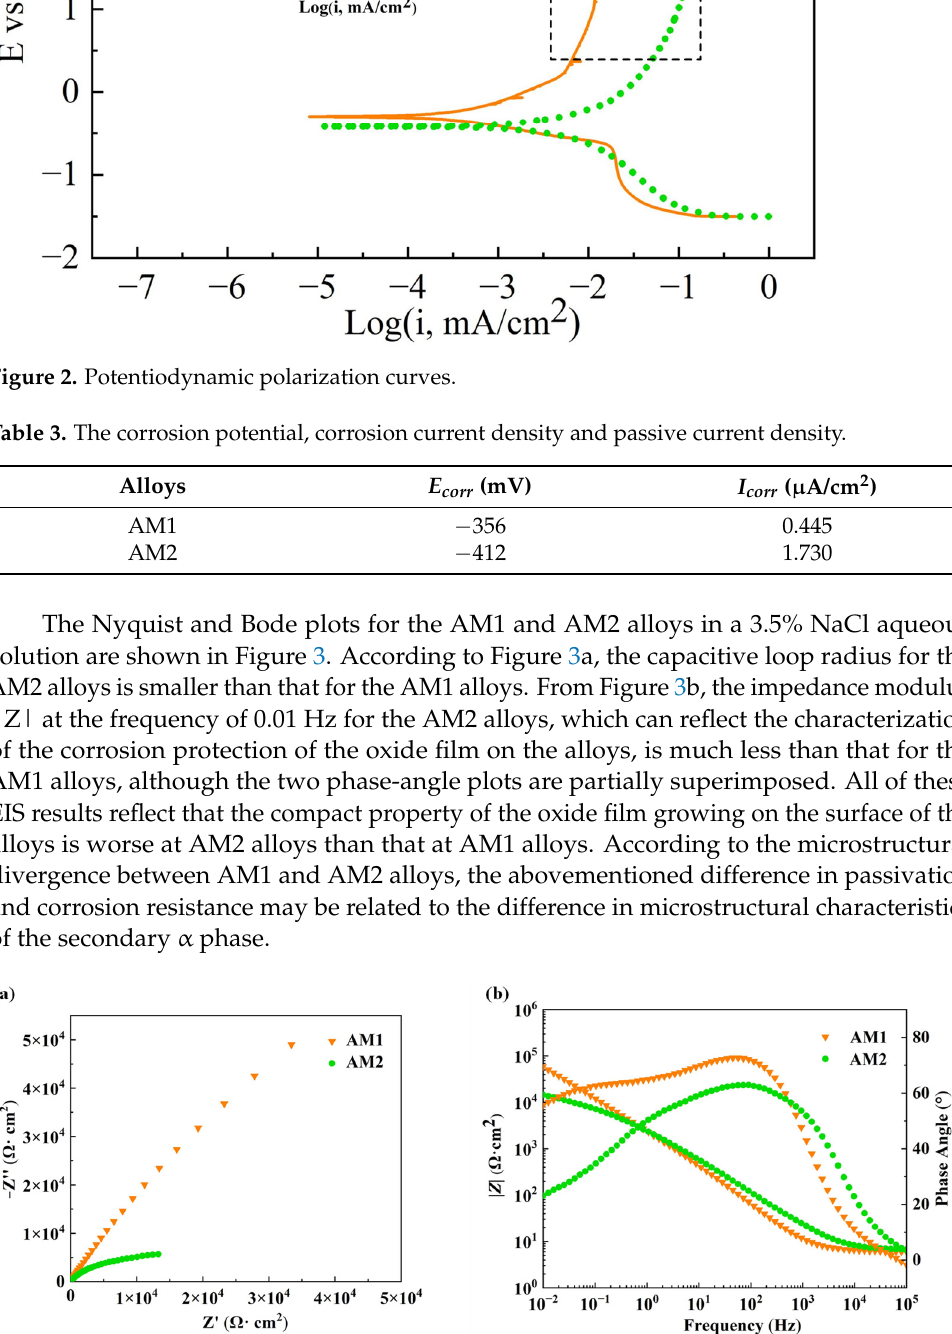
Figure 3. ( a ) The Nyquist plots measurement; ( b ) Bode plots measurement of the AM1 and AM2